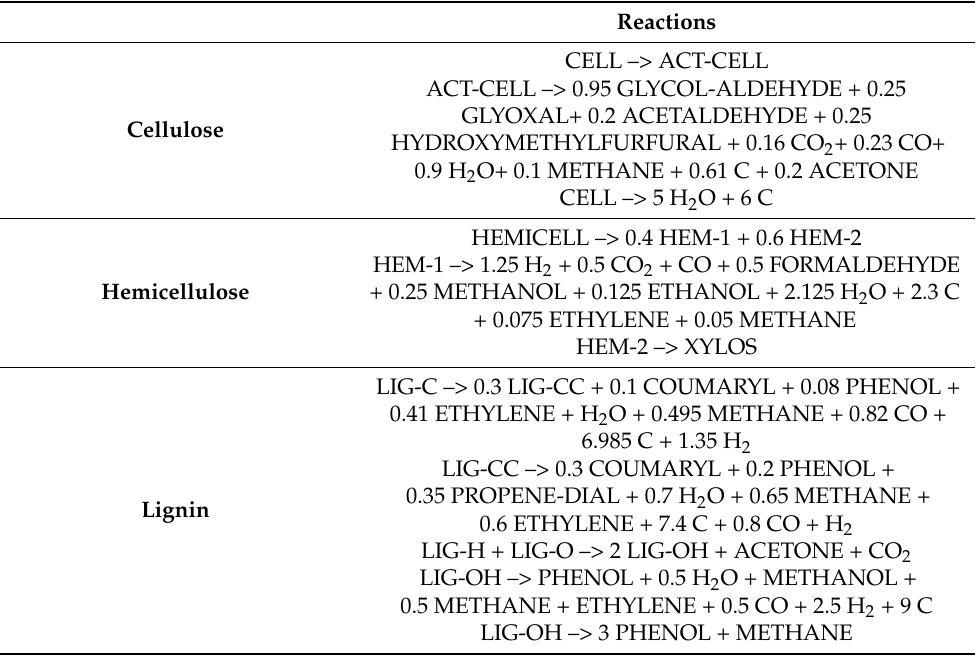
Table 8. Multi-step kinetics reactions in biomass